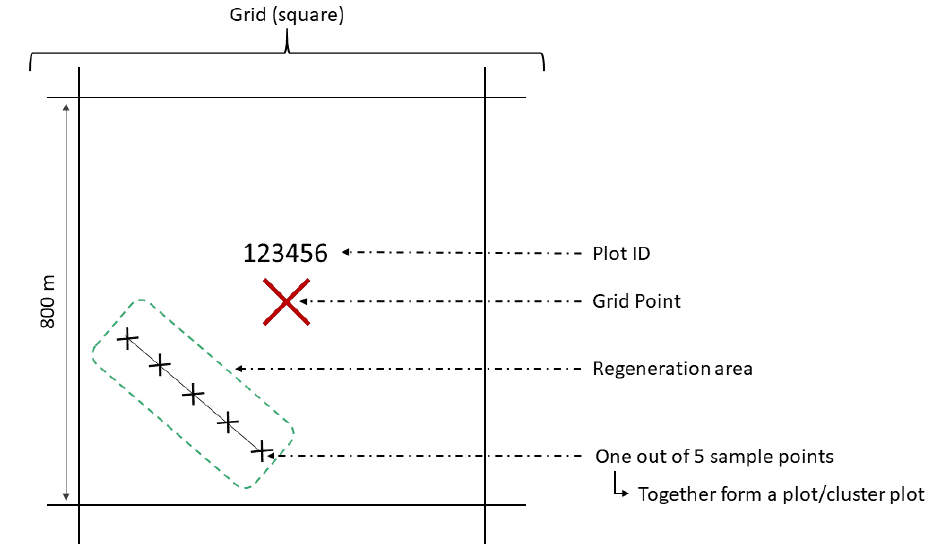
Figure 1. Overview of the regeneration inventory and its terms. To cover spatial browsing variation inside a regeneration area, a transect of at least 40 m (maximum 100 m) length is laid through the widest section of the regeneration area. Five sample points are mapped on the straight transect at intervals each corresponding to a quarter of the transect length. The first and the last sample points have to be at least 5 m away from the edge of the regeneration area. The coordinates in the center of the first sample point are recorded. Together, all sample points of a regeneration area form a (cluster) plot (see Figure 1). Each cluster plot is individualized by a plot ID [52,93]. Starting from the center of each sample point, the 15 closest individual seedlings are examined, which fulfill the height requirements (20–200 cm). The distance of the 15th recorded regeneration plant to the center of the sample point corresponds to the sample points’ radius. On each seedling inventoried, tree species and height are determined. To monitor the browsing injuries on the terminal shoot that occurred since the beginning of the last vegetation period, binary notation was